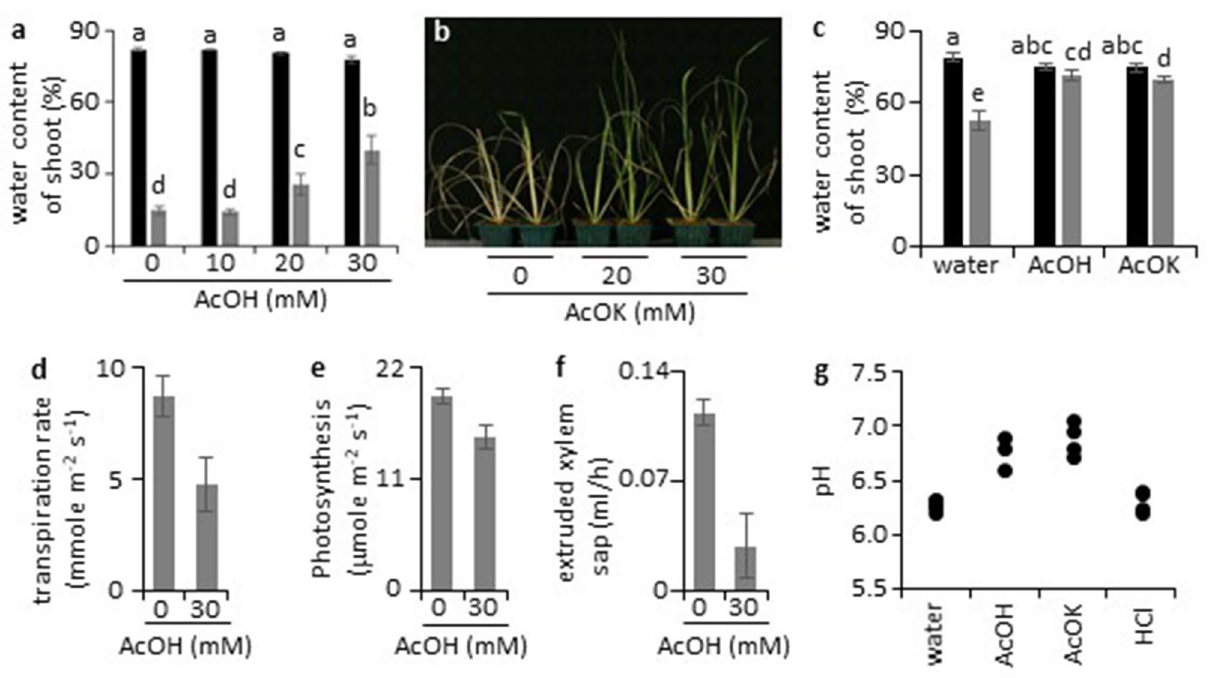
Figure 1. Acetic acid induces physiological changes resembling responses to drought in rice. ( a ) Water content of shoots treated with acetic acid under drought conditions. Two-week-old rice plant roots were treated with acetic acid (AcOH) solutions for 4 days; plants were then subjected to drought stress for a further 4 days. Statistical significance was examined by the Tukey Kramer method (p < 0.01). Black bars, before drought exposure; gray, day 4 of drought conditions; error bars, mean ± SD; n = 5 or 6. ( b ) Drought avoidance of rice induced by potassium acetate. Two-week-old rice plants were treated with potassium acetate (AcOK) for 4 days and then grown under drought conditions for 4 days. After drought treatment, plants were rewatered and grown for 4 days. ( c ) Water content of plants treated with acetic acid or potassium acetate. Water content of shoot of acetic acid or acetate-treated rice plants was measured before and after 2-day drought exposure. Statistical significance was examined by Tukey’s method (p < 0.01). Black bars, day 0; gray, day 2; error bars, mean ± SD; n = 8. ( d–f ) Physiological changes in acetic acid-treated rice plants. Two-week-old rice plants were treated with 0 or 30 mM acetic acid for 2 days. Transpiration rate ( d ), photosynthesis activity ( e ), and flow rate of xylem sap ( f ) are shown. Statistical significance was examined by Student’s t-test (p < 0.01). Mean ± SD; n = 4. ( g ) Xylem sap pH of rice plants treated with water, 30 mM acetic acid, 30 mM potassium acetate and 30 mM hydrochloric acid (HCl) for 2